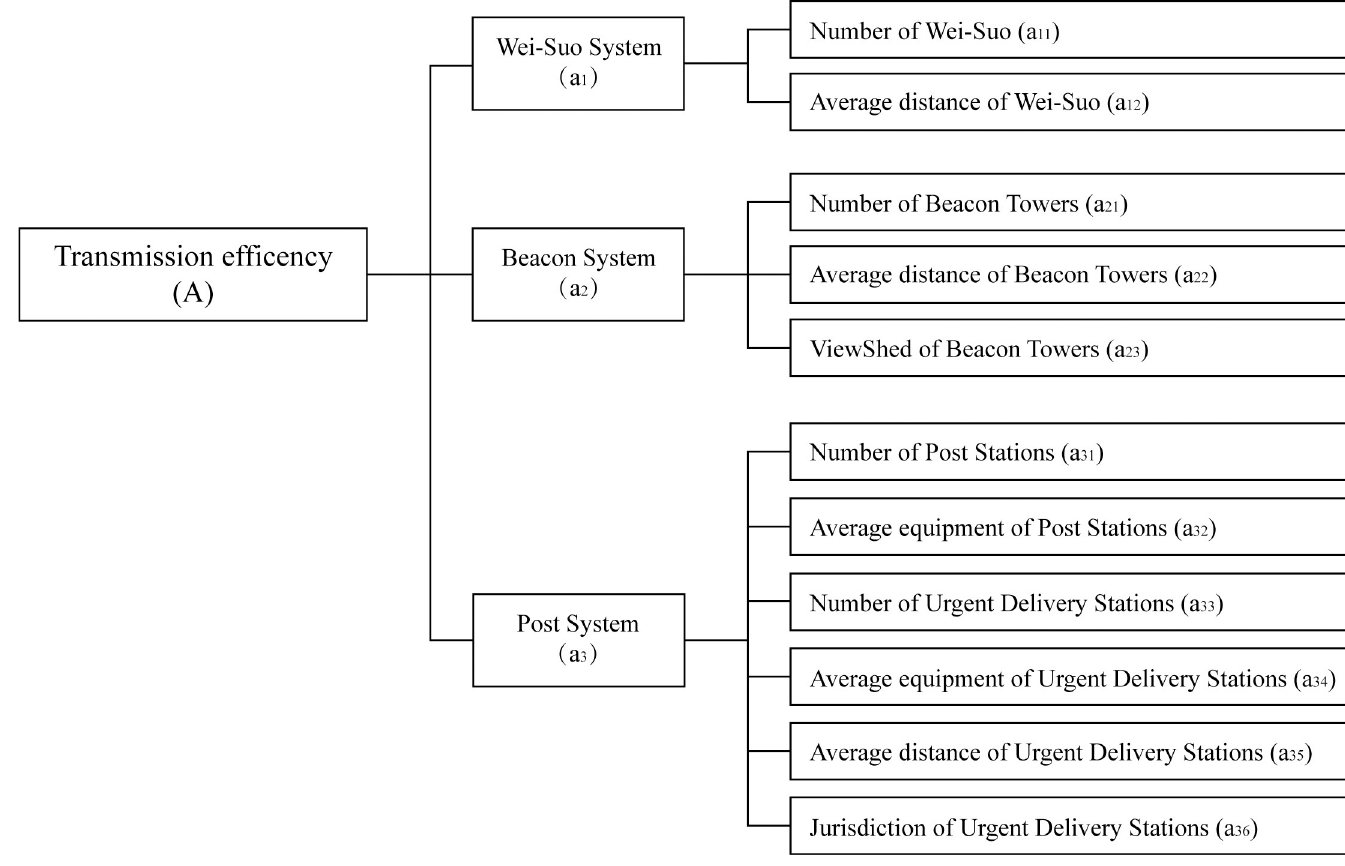
Fig 4. Hierarchy evaluation model of the information transmission efficiency.